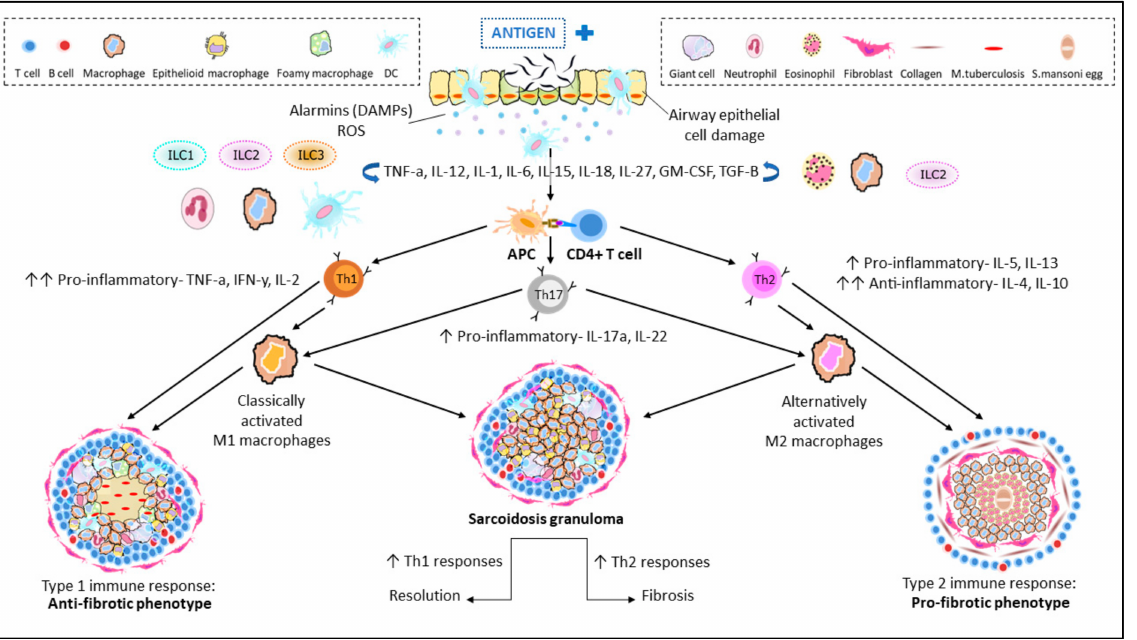
Figure 1. Immunopathogenesis of granulomatous diseases of the lung. Entry of an unknown airborne antigen simultaneously activates interstitial dendritic cells (DCs) and alveolar macrophages (AM), resulting in the eventual cellular damage of airway epithelial cells. Cellular damage induces the secretion of alarmins; a subgroup of damage-associated molecular patterns (DAMPs) and reactive oxygen species (ROS) that triggers the continuous secretion of key cytokines: TNF- α and IFN- γ and differentiation of CD4 + T cells (Th0). Upon antigen presentation to Th0, the host responds by differentiation and clonal expansion of Th1/Th2/Th17 subsets. Production of respective cytokines for Th differentiation is also triggered with the help of circulating macrophages, innate lymphoid cells (ILCs) and DCs to produce effector cytokines. Persistent stimulation and cellular recruitment over time eventually leads to formation of granulomas. A Th1-driven response leads to an anti-fibrotic granuloma phenotype, resembling a typical TB granuloma with its macrophage-rich core. On the other hand, Th2 cytokines contribute towards a pro-fibrotic granuloma with a characteristic